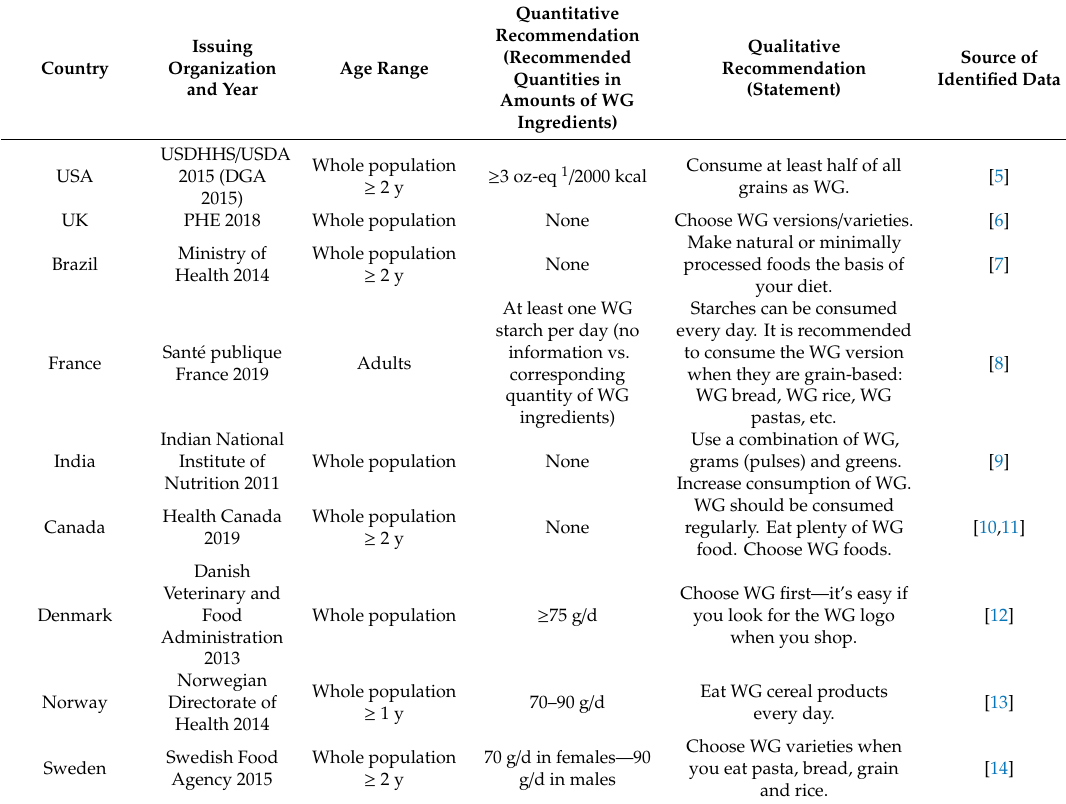
Table 1. Recommendations regarding the consumption of whole grains as included in national dietary guidelines of several countries